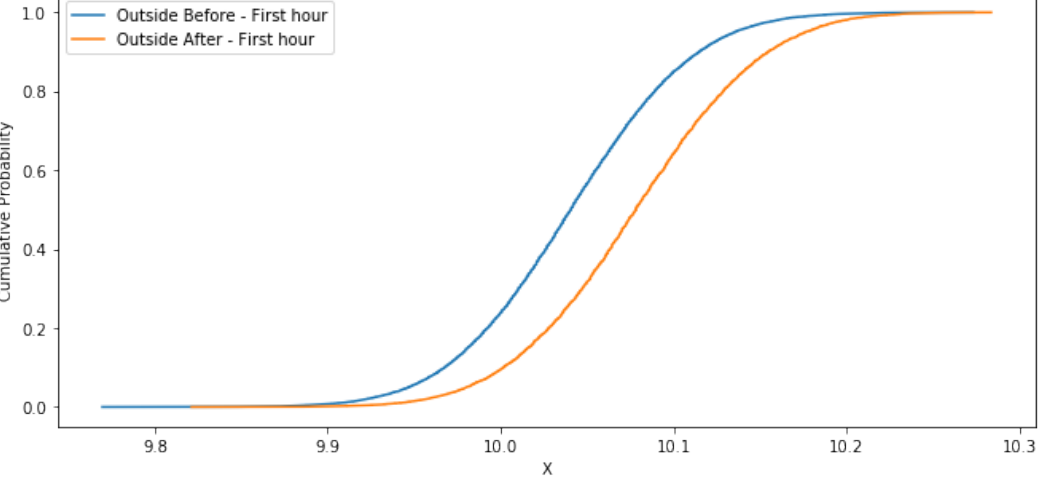
Figure 19. Cumulative Distribution Function for the outside sensor, before and after inserting the RPWs for the first